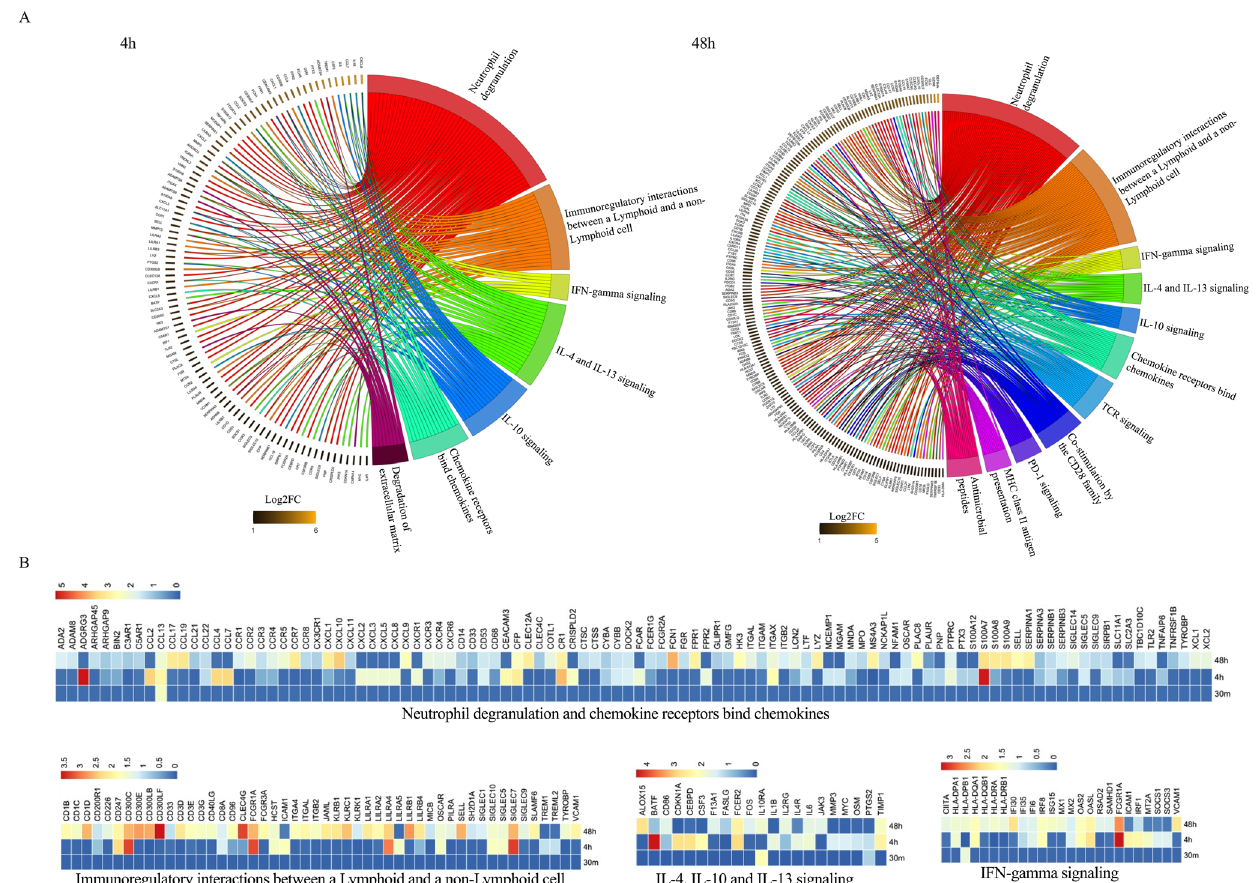
Fig.4|Pathwayanalysisresultingfrom Aedesaegypti mosquitobitesovertime. A Chord plot shows signi fi cantly upregulated genes at 4h and 48h post-bite over NSK (left side of chord plot) and overrepresented pathways (right side of chord plot). Outer left ring shows genes and color range displays log2 fold change (FC)